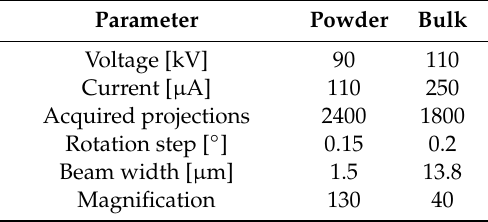
Table 3. X-ray measurement